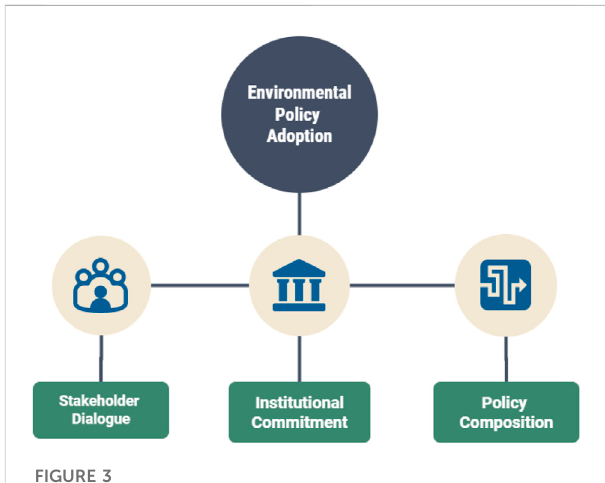
FIGURE 3 Diagrammatic illustration of policy adoption